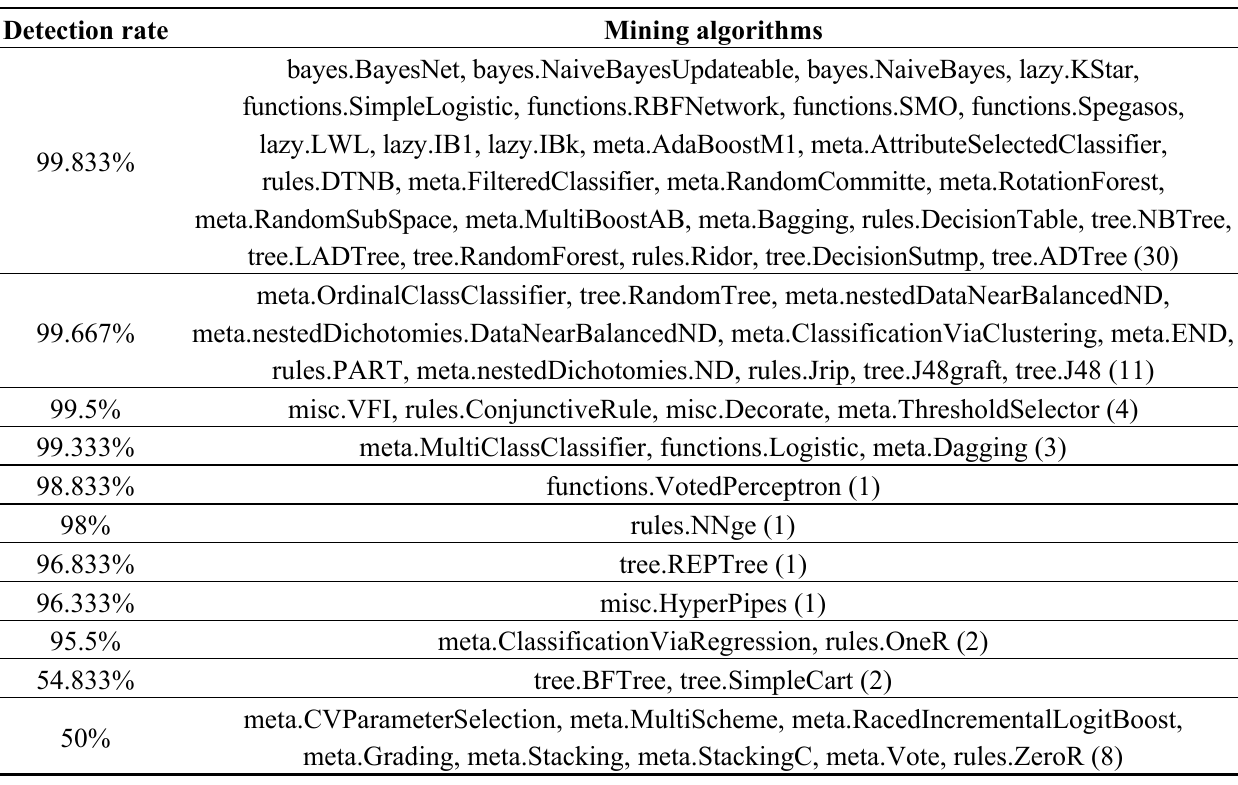
Table 2. SYN flood attack—data mining